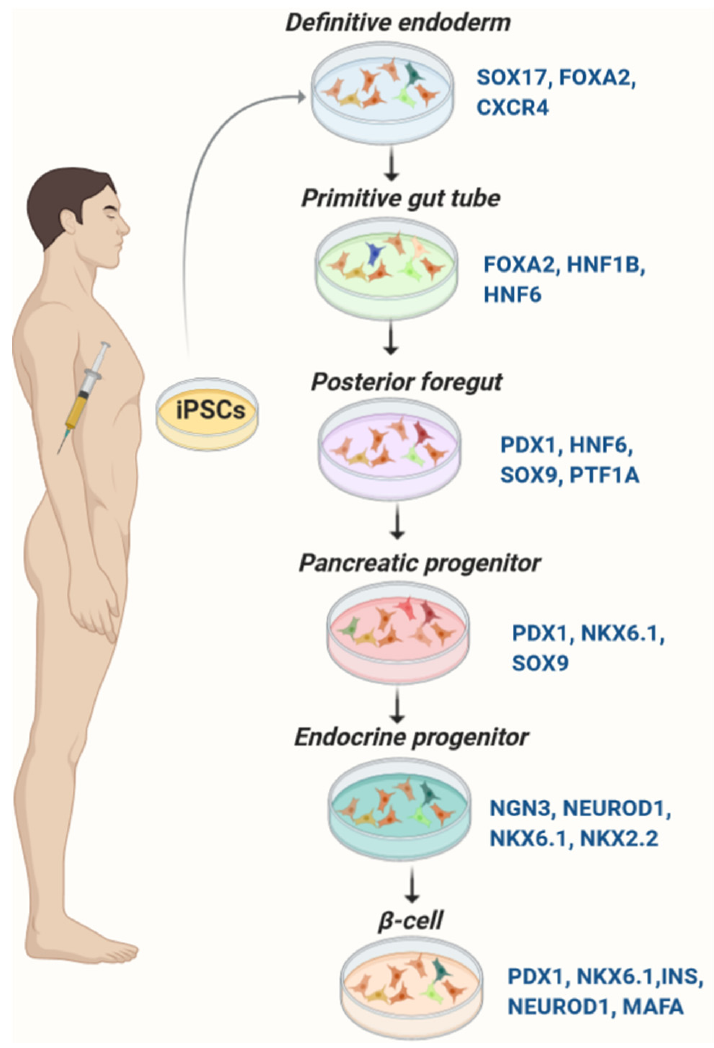
Figure 1. Differentiation of pancreatic β -cells from iPSCs. Expression of the key transcription factors is monitored for evaluation of the consecutive stages of differentiation.